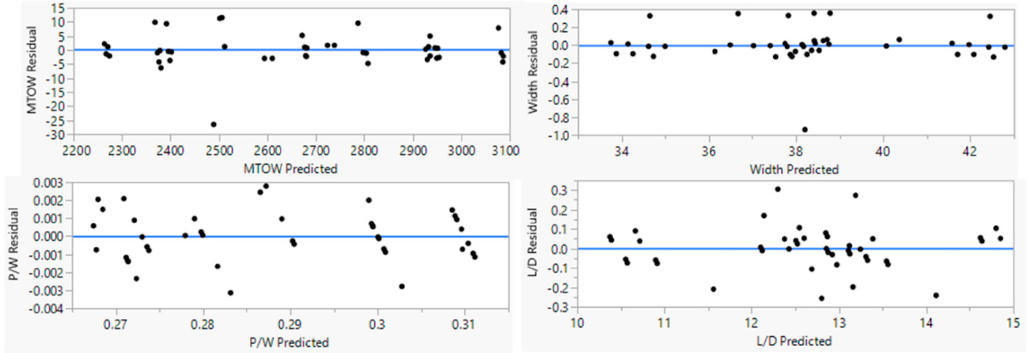
Figure 15. Response surface method residual graph.